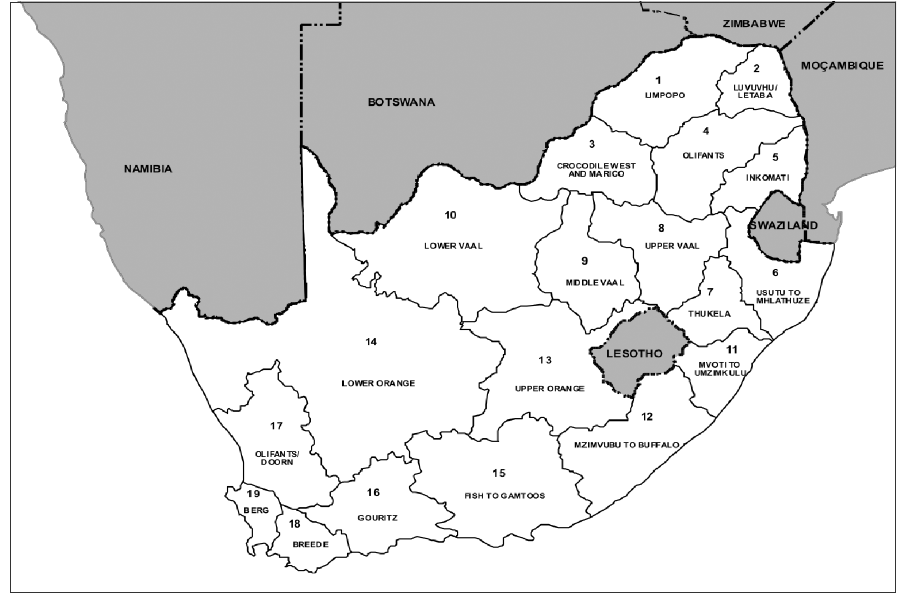
Figure 1. The nineteen catchment management areas identified by DWAF.